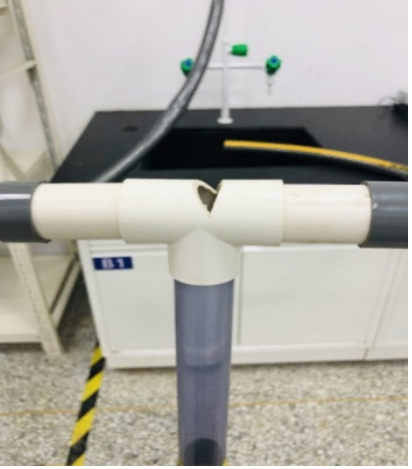
Figure 13. A diagram of a three-way drainage pipe balancing atmospheric pressure.